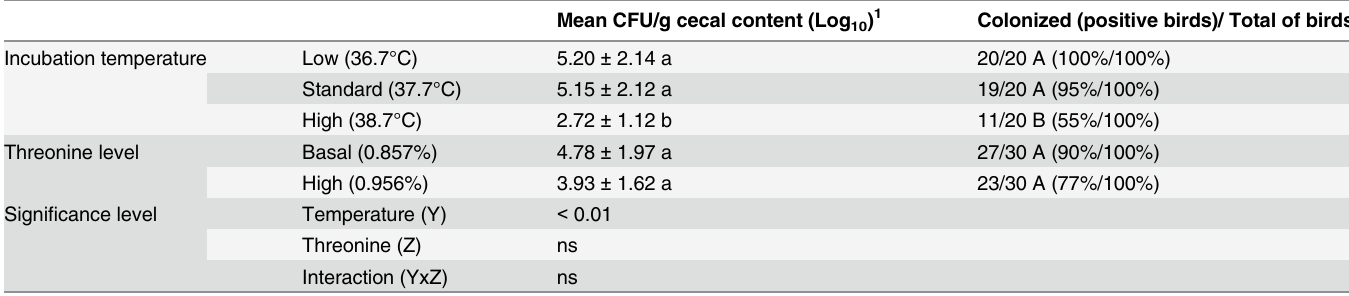
Table 1. Salmonella counts in the cecal contents (Log 10 CFU/g) and number of colonized (positive) birds (8dpi) submitted to thermal manipulation during incubation and fed different threonine levels post-hatch (n = 10 per treatment).